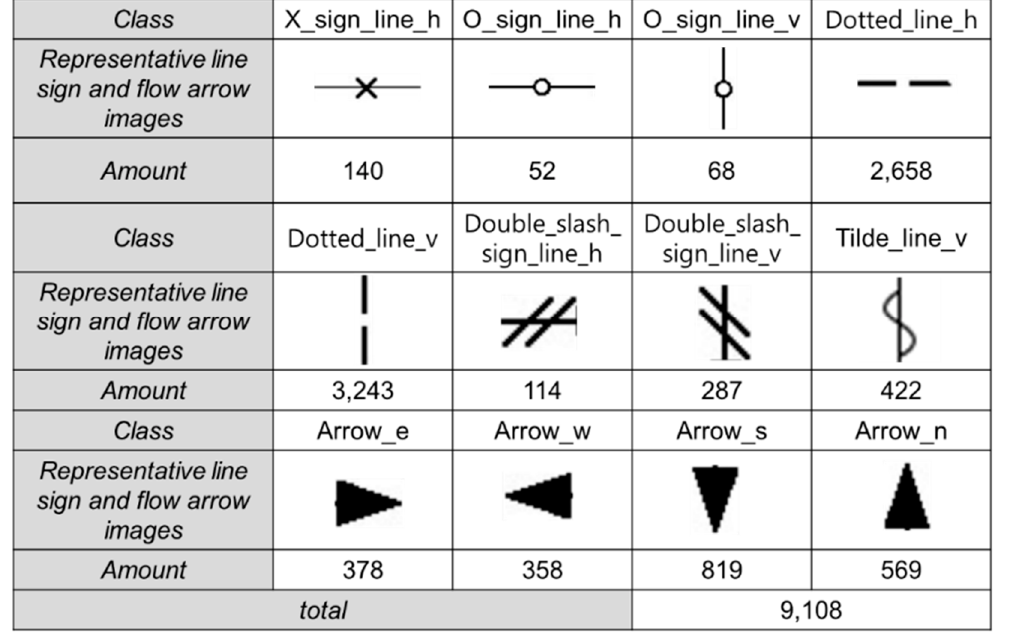
Figure 6. Summary of an initial dataset for line objects.